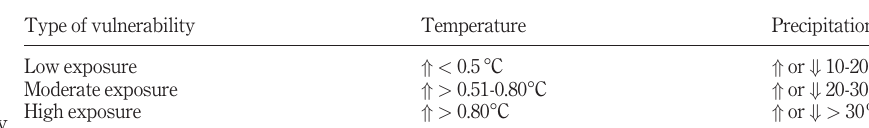
Table III. Description of the types of vulnerability defined for Colombia based on temperature and precipitation